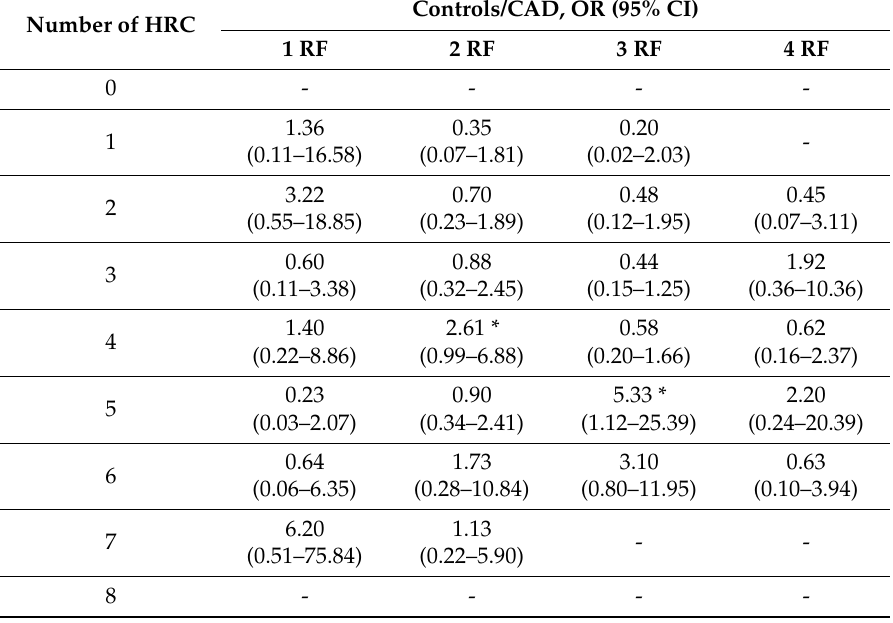
Table 4. Association between frequencies of homozygous recessive characteristics regarding the presence of coronary artery disease and number of risk factors versus controls. Controls/CAD, OR (95% Number of HRC